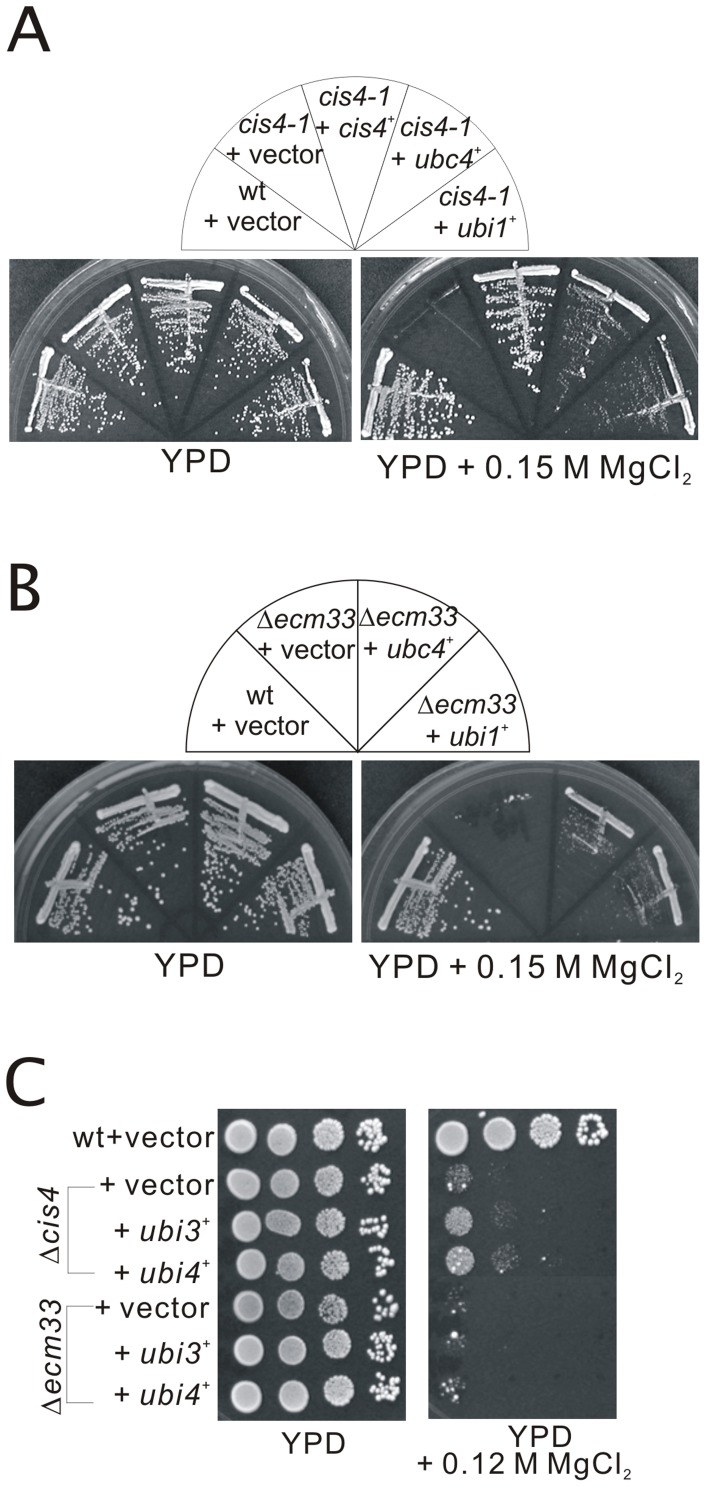
Isolation of Ubi1 and Ubc4 as multicopy suppressors of the cis4-1 mutant cells.(A) The cis4-1 mutant cells were transformed with either the pDB248 multicopy vector, or the vector containing ubi1
+ or ubc4
+. Cells were then streaked onto plates containing YPD, or YPD plus 0.15 M MgCl2, and then incubated for 4 days at 30°C. (B) The Δecm33 cells were transformed with either the pDB248 multicopy vector, or the vector containing ubi1
+ or ubc4
+. Cells were then streaked onto plates containing YPD, or YPD plus 0.15 M MgCl2, and then incubated for 4 days at 30°C. (C) The Δecm33 and Δcis4 cells were transformed with either the pDB248 multicopy vector, or the vector containing ubi3
+ or ubi4
+. Cells were then spotted onto plates containing YPD, or YPD plus 0.12 M MgCl2, and then incubated for 4 days at 30°C.